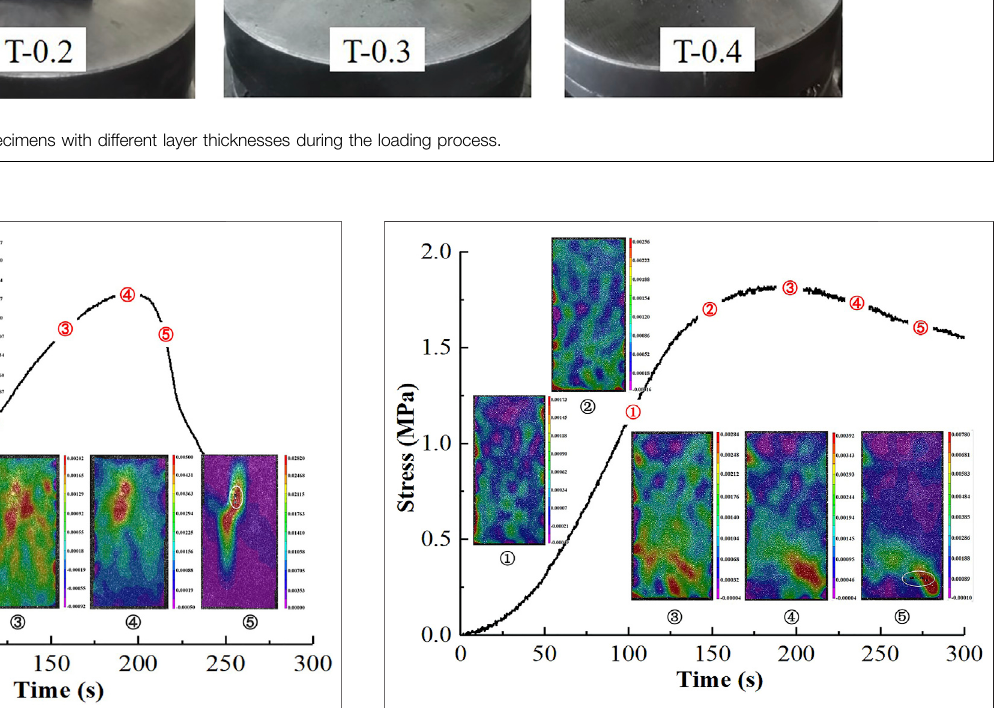
FIGURE 10 | The apparent strain fi eld of T-0.2.